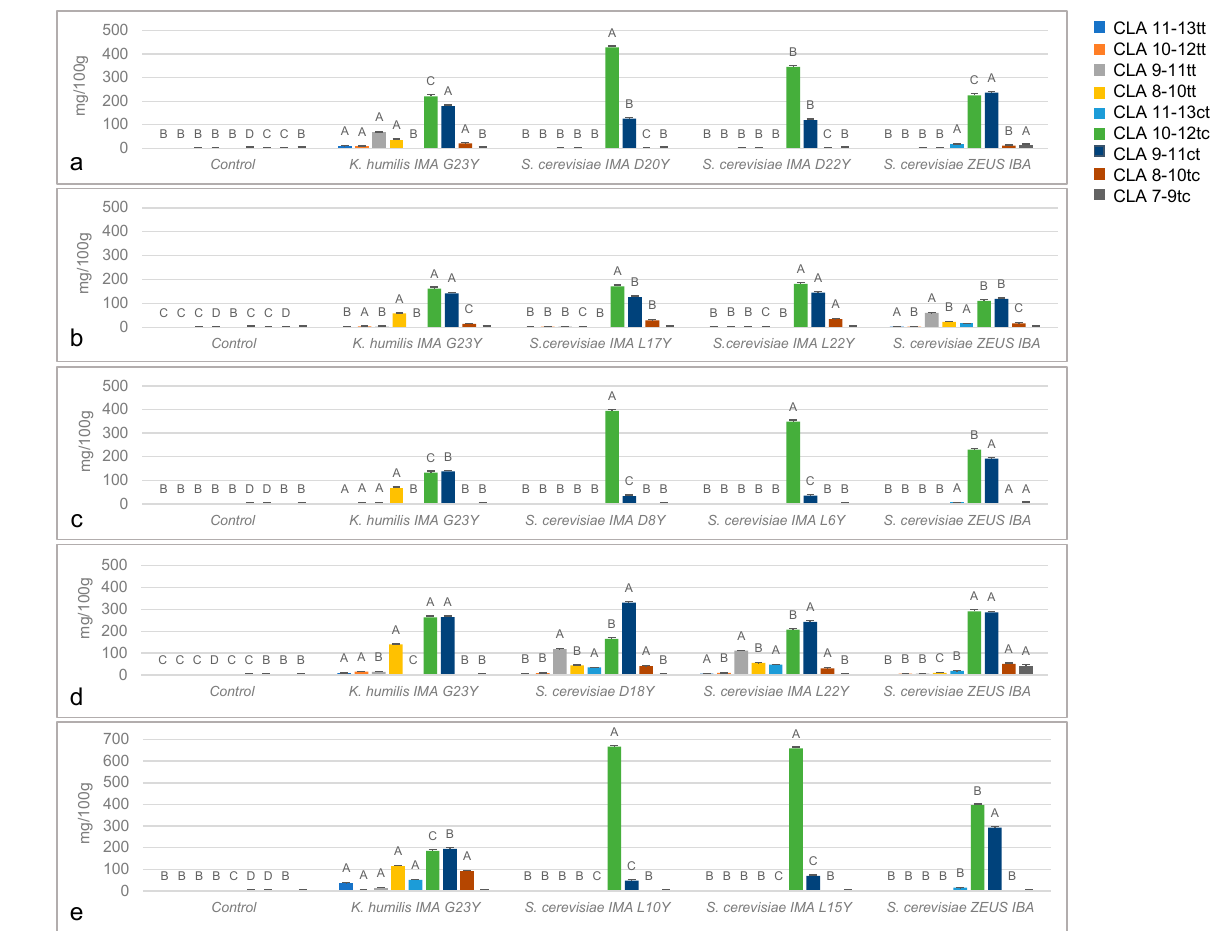
Figure 3. Histogram showing conjugated linoleic acid (CLA) (mg/100 g of total lipids) profiles of fermented doughs individually inoculated with the yeast strains, obtained using ( a ) conventional red-grained wheat variety T. aestivum L. cv Aubusson, ( b ) yellow-grained wheat variety T. aestivum L. cv Bona Vita, ( c ) blue-grained wheat variety T. aestivum L. cv Skorpion, ( d ) winter emmer variety Triticum turgidum subsp. dicoccum var. Schrank , Giovanni Paolo and ( e ) hull-less spring barley variety Hordeum vulgare L. var. nudum Hook , Rondo. A–D: means within CLA isomers with different letters significantly differ ( p ≤ 0.01).